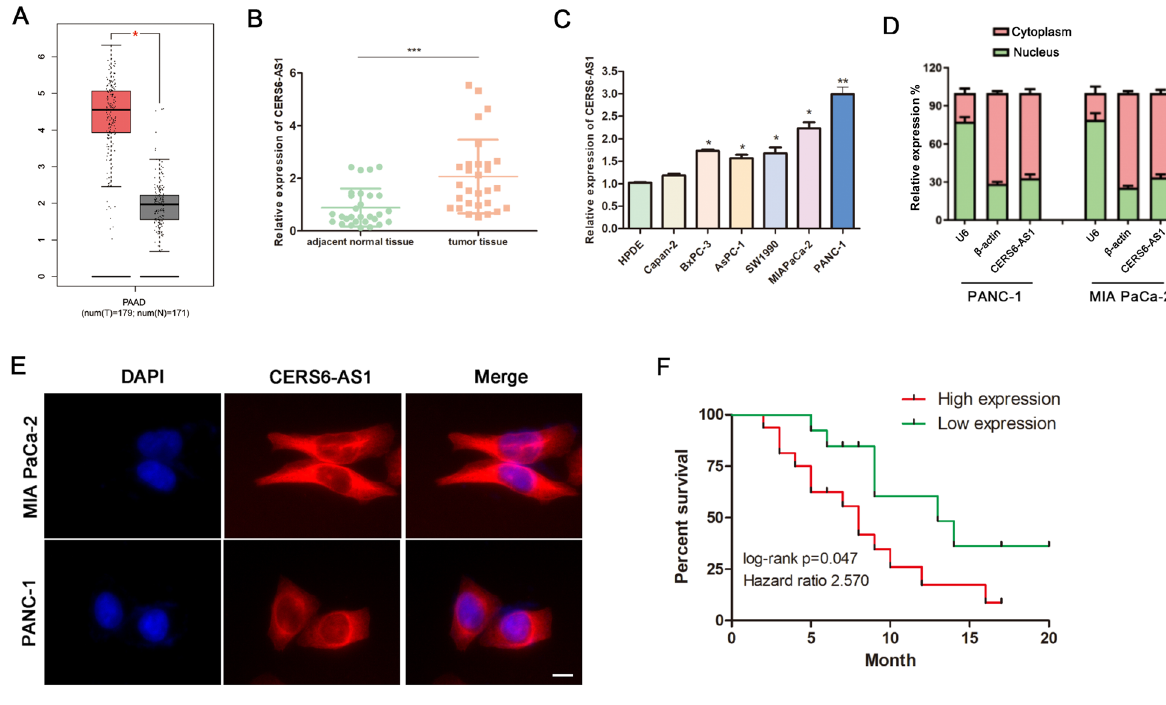
Fig. 1 CERS6-AS1 expression is upregulated in PC and associated with poor prognosis. A The expression of CERS6-AS1 in PC tissues obtained from the TCGA database. B RT-qPCR analysis of CERS6-AS1 expression in PC tissues. C A differential expression pattern of CERS6-AS1 was observed in PC cell lines. D The relative expression of CERS6-AS1 in nucleus and cytoplasm, the U6 and β -actin were used to serve as the internal reference of nucleus and cytoplasm respectively. E RNA-FISH localization of CERS6-AS1 in PC cells (scale bar: 12.5 μ m). F Survival curve of PC patients with high and low CERS6-AS1 expression. All experiments were performed three times and data were presented as mean ± SD. * p < 0.05, ** p < 0.01, *** p <